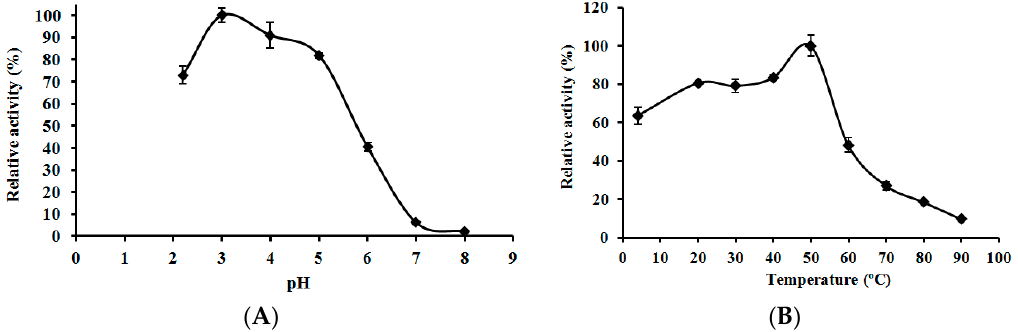
Figure 5. ( A ) Effect of pH on laccase activity of Lepista nuda laccase. Results represent mean ± SD ( n = 3). ( B ) Effect of temperature on laccase activity of Lepista nuda laccase. Results represent mean ± SD ( n = 3)